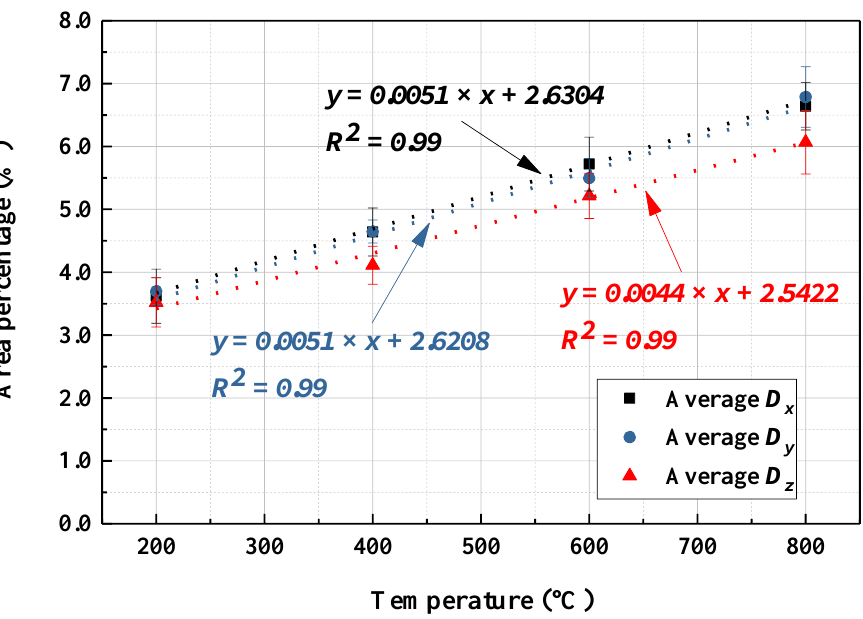
Figure 13. Average porosity of SIC norite in each direction.